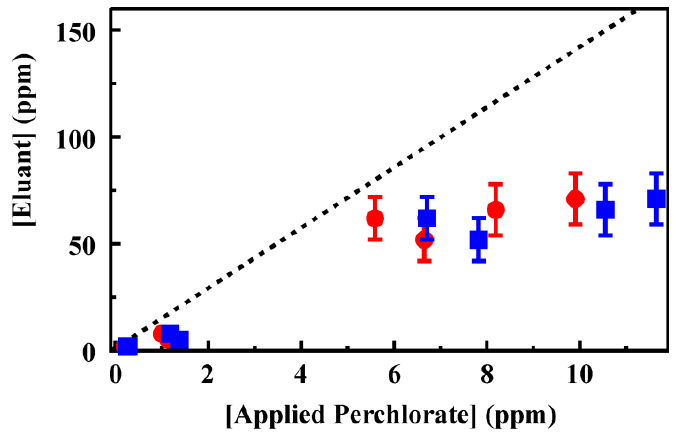
Figure 6. Perchlorate recovery from groundwater using a 200 mg column of